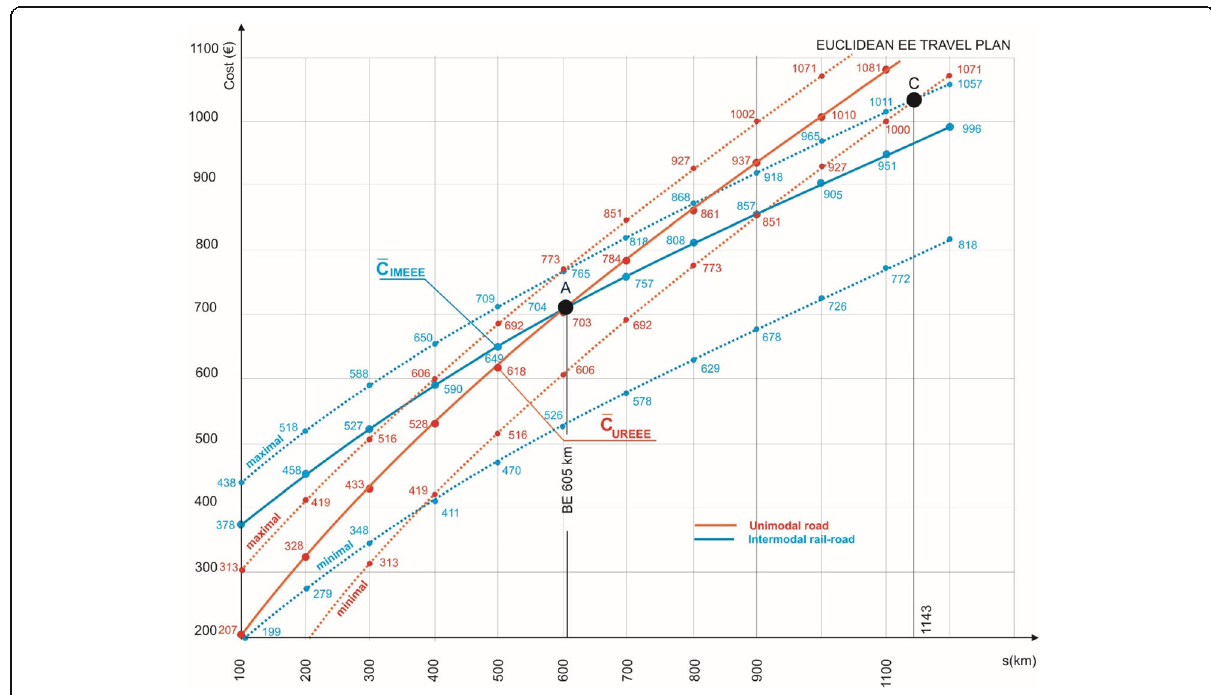
Fig. 7 Cost functions and break-even distances (Euclidean EE)